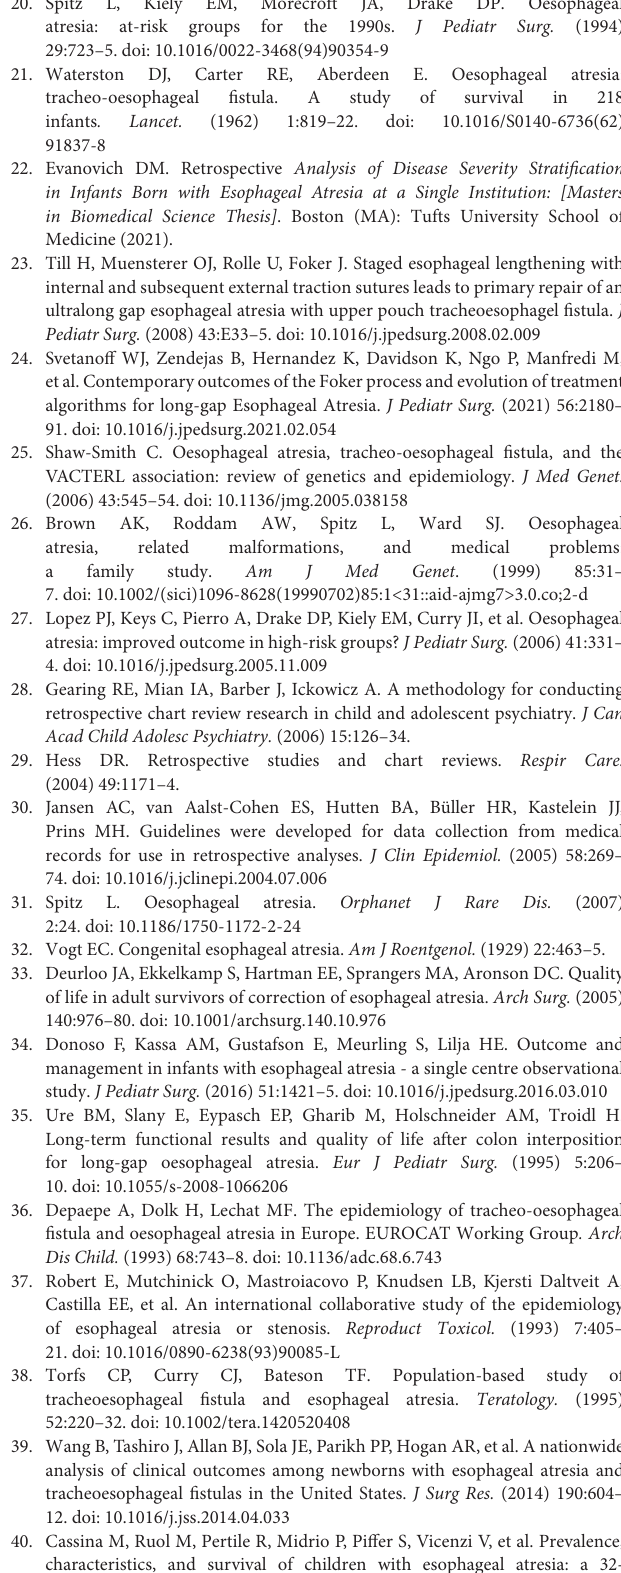
characteristics, and survival of children with esophageal atresia: a 32- year population-based study including 1,417,724 consecutive newborns.